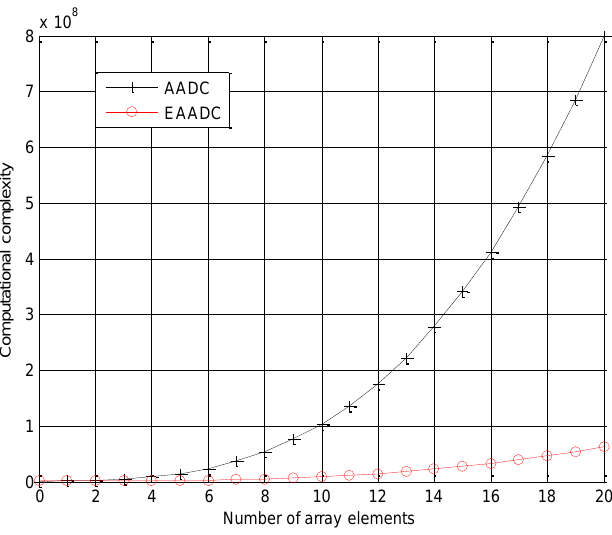
Figure 8. The main computation complexities of AADC and